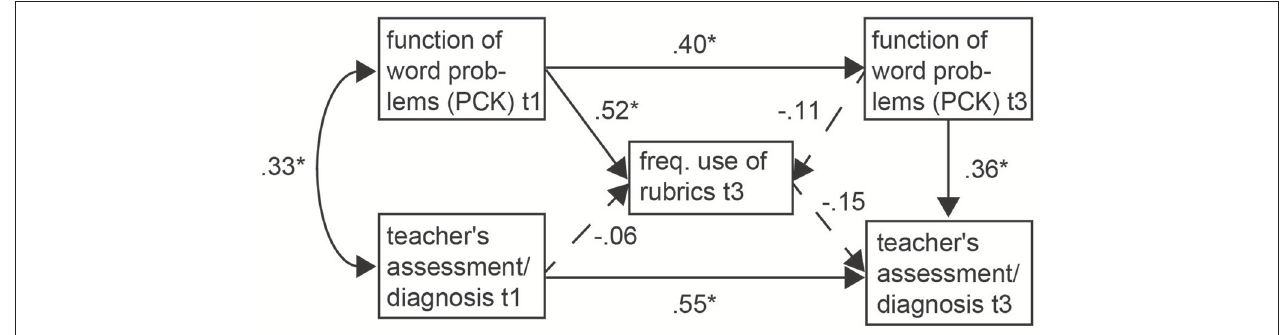
FIGURE 3 | SEM model for the influence of teachers’ knowledge about word problems on the use of rubrics and on teachers’ assessment competence (teacher perceptions). N = 42; * p < 0.05; (PCK) = pedagogical content knowledge. All estimates are